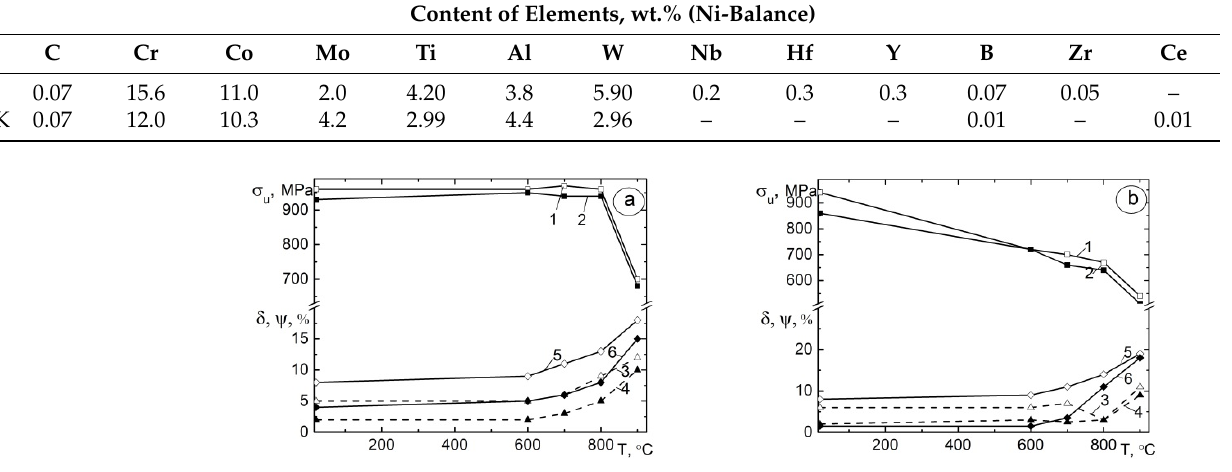
Figure 6. Temperature dependence of the coefficient of influence of hydrogen at a pressure of 30 MPa on the reduction of area β ψ of samples from alloys CM-88Y (1) and ZhS3DK (2). High-cycle fatigue (HCF) is an important characteristic of the performance of rotating parts of power equipment, such as rotors, discs and blades of turbines and engines [46–